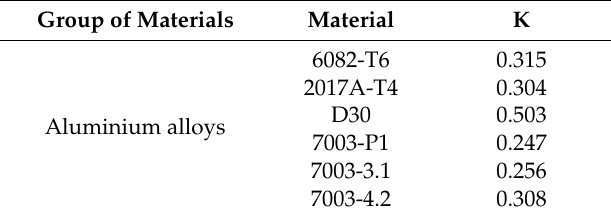
Figure 4. Variability of parameter B in relation to the value of β angle for analyzed aluminium alloys. Table 4. Summary of K values for aluminium